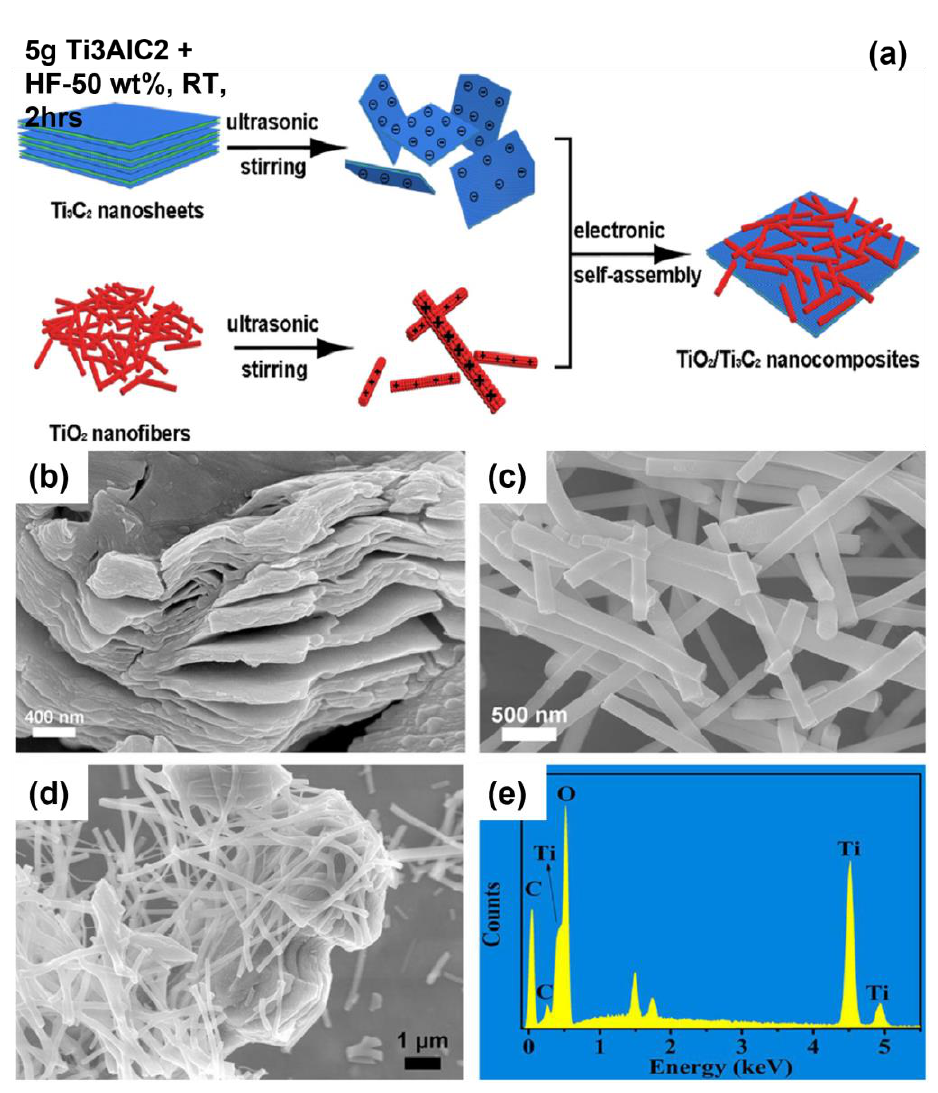
Figure 8. ( a ) Schematic description for the synthesis of M-MXene/TiO 2 composite SEM images of ( b ) TiO 2 , ( c ) MXene, and ( d , e ) MXene/TiO 2 nanofibers. (Reprinted with permission from Ref. [17]. 2019 Elsevier). Table 5. Summary of TiO 2 -MXene-based photocatalyst synthesis techniques.